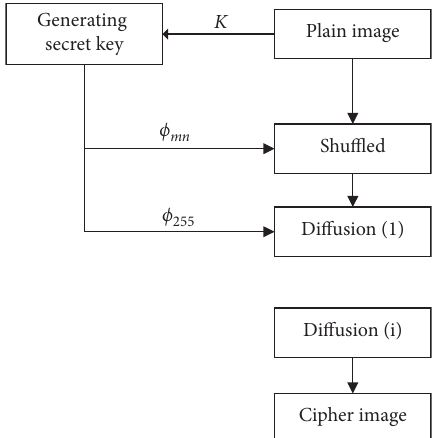
Figure 7: The block diagram of encryption